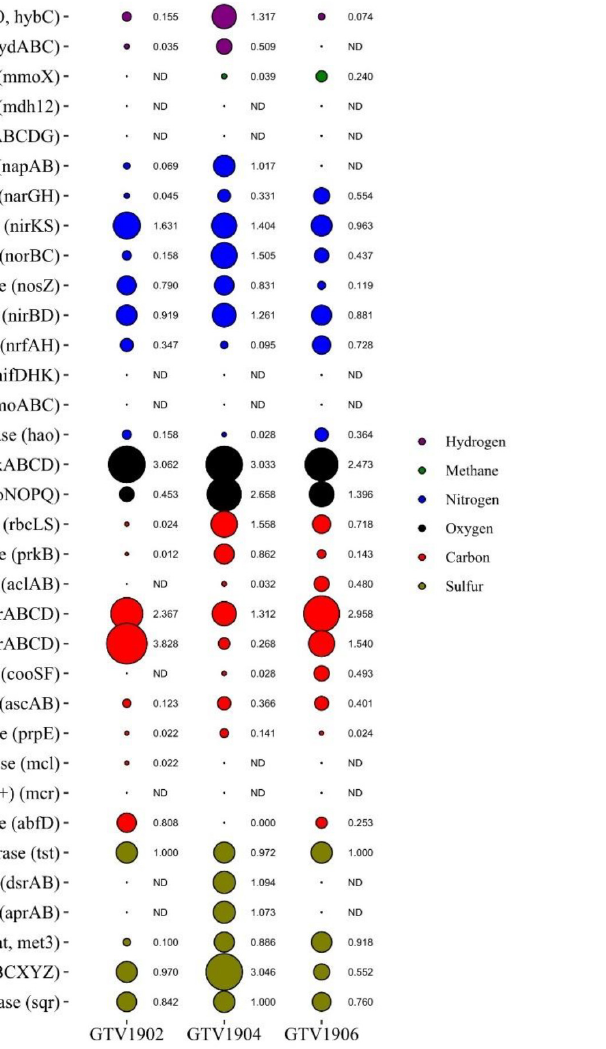
GTV1902 (Invent E) compared to GTV1904 and